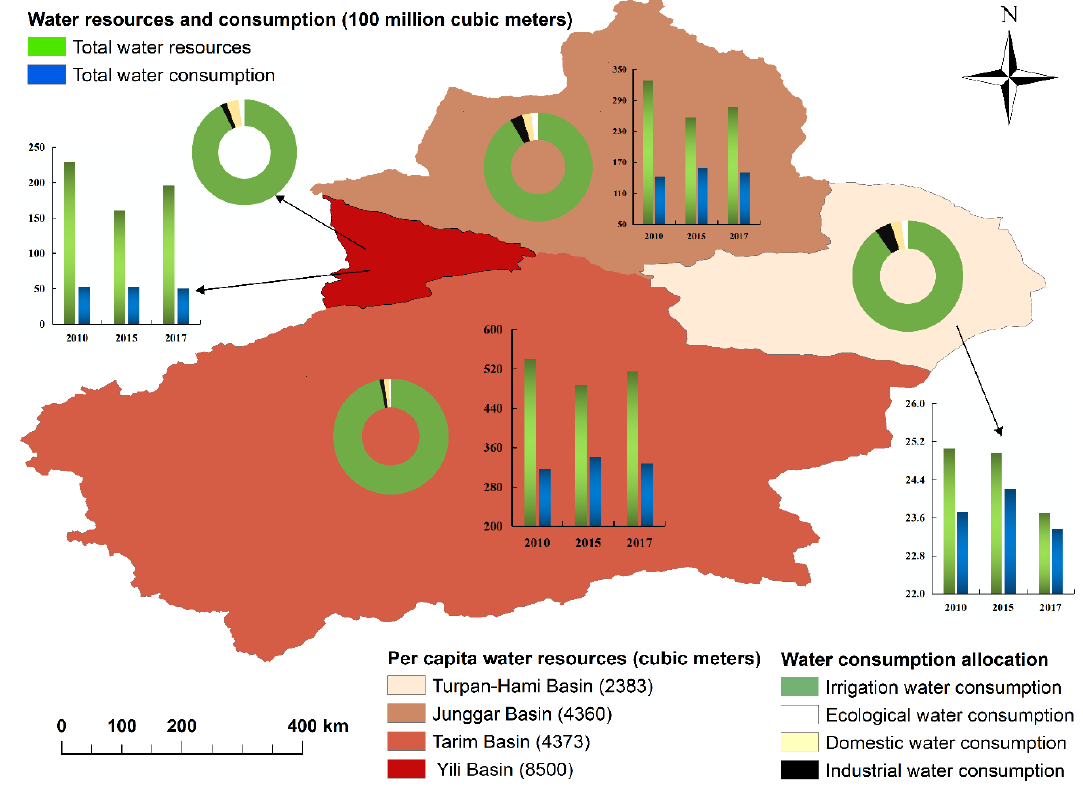
Figure 4. Development and utilization of water resources in sub-regions of Xinjiang (2016). The pie chart represents the allocation of water consumption, and bar chart represents the changes in water consumption and water resources.